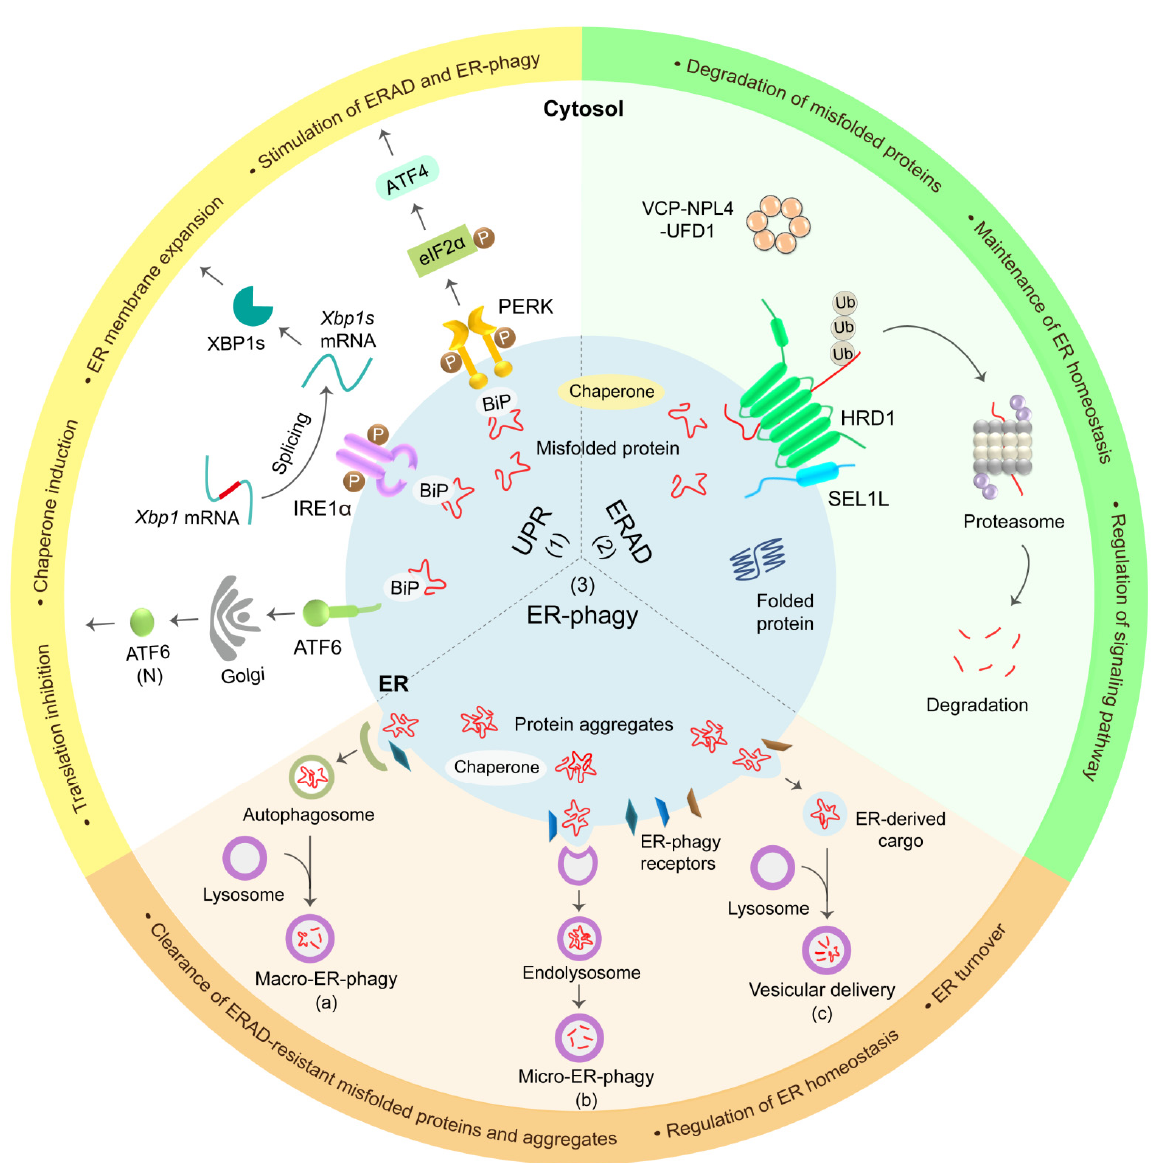
Figure 1. Overview of ER protein quality control system in mammals. ( 1 ) UPR: misfolded proteins activate three UPR sensors, protein kinase RNA (PKR)-like ER kinase (PERK), inositol-requiring protein 1 α (IRE1 α ), and activating transcription factor 6 (ATF6), which subsequently initiate their downstream signaling pathways to inhibit protein transla- tion, increase ER folding and degradation capacity, promote ER biogenesis, and if the stress is unresolved, trigger cell death. ( 2 ) ERAD : misfolded proteins are recruited to the ERAD complex for degradation. ER chaperones and lectins me- diate the substrate recognition and recruitment to the SEL1L-HRD1 ERAD protein complex. Assisted by AAA-ATPase valosin-containing protein (VCP) and other shuttling factors, ubiquitinated ERAD substrates are delivered to the pro- teasome for degradation. ( 3 ) ER-phagy: insoluble protein aggregates in the ER can be cleared via three ER-phagy path- ways: ( a ) macro-ER-phagy mediated by autophagosome formation and its subsequent fusion with lysosome for degra- dation; ( b ) micro-ER-phagy; or ( c ) LC3-dependent vesicular delivery mediated by the engulfment of ER portion by en- dolysosomes or direct fusion of ER vesicles with lysosomes, respectively. Membrane-bound or soluble ER-phagy recep- tors define the specificity of ER-phagy. Under pathological conditions, an insufficient activity of ERAD and ER-phagy may lead to elevated protein misfolding and aggregation, thus causing the activation of UPR.